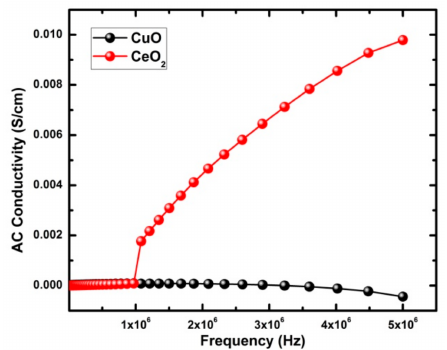
Figure 5. Variation of AC conductivity with